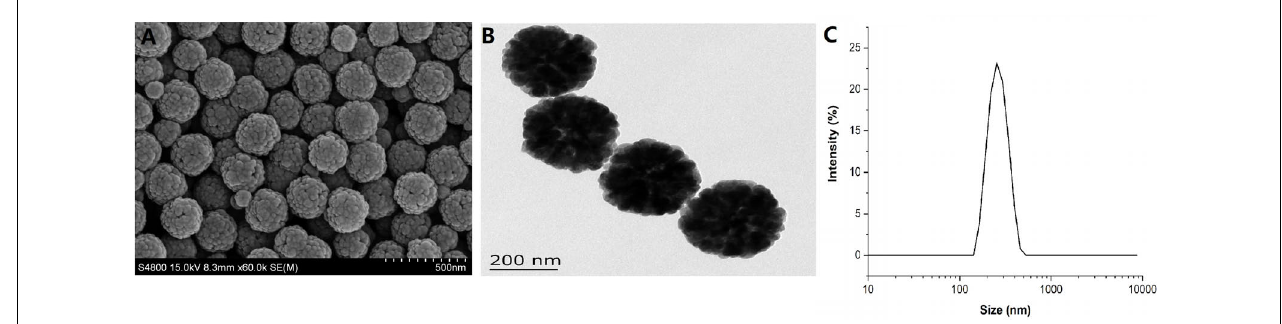
FIGURE 1 | Characterization of Fe 3 O 4 magnetic nanoparticles. (A) Representative scanning electronic microscopy (SEM) images of Fe 3 O 4 -NPs (scale bar = 500 nm). (B) Representative transmission electron microscopy (TEM) images of Fe 3 O 4 -NPs (scale bar = 200 nm). (C) Dynamic light scattering (DLS) of Fe 3 O 4